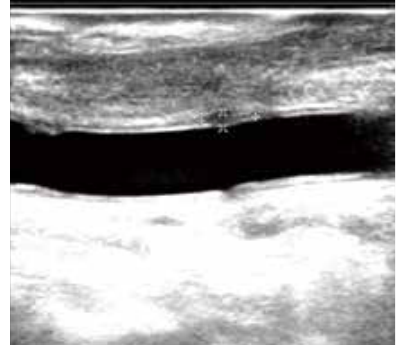
Figure 7 2D structure of the hematoma dissection in the anterior and posterior wall of the left common carotid artery.